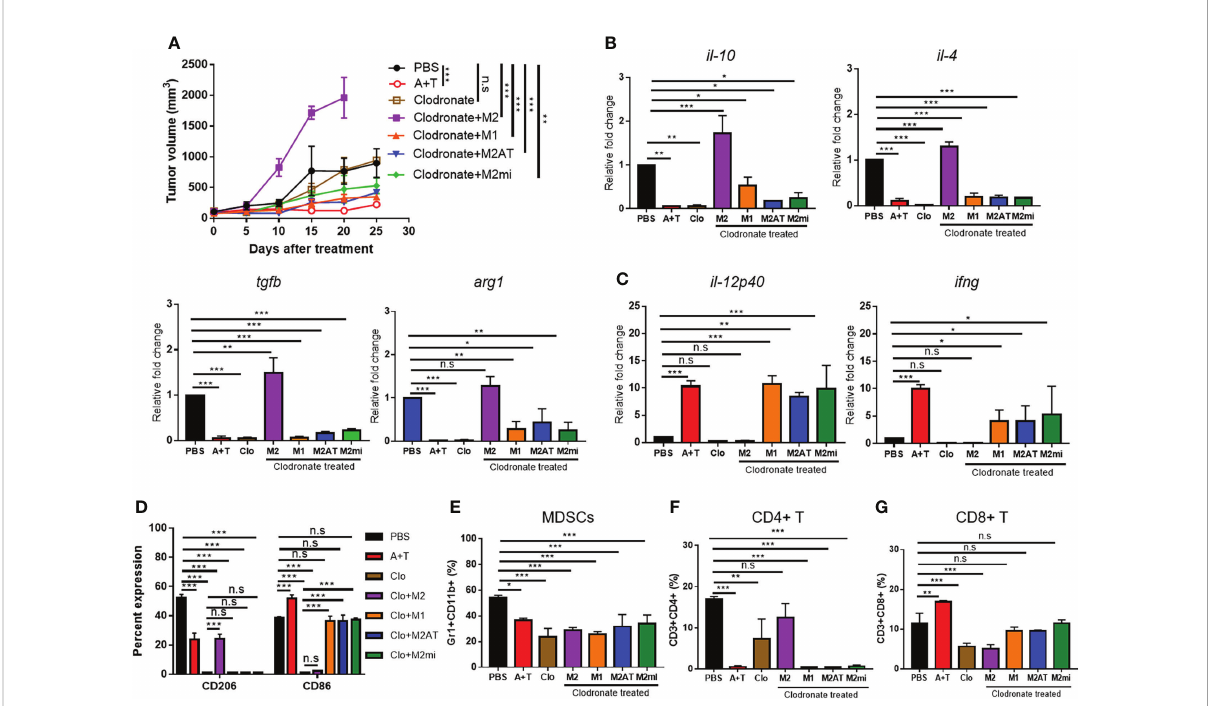
FIGURE 6 Adoptive transfer of M2 macrophages pre-treated with miR-7083-5p or combination of 5-aza-dC and TSA reduces tumor growth. (A) Tumor volumes after treatment of 4T1 tumor-bearing mice with clodronate and subsequent adoptive transfer of M2 macrophages pre-treated with miR-7083-5p (M2mi) or combination of 5-aza-dC and TSA (M2AT). M1 and M2 macrophages were included as control. (B, C) qRT-PCR analysis of the relative mRNA levels of M2- (B) and M1-type (C) cytokines and markers in tumor tissues after treatments. (D – G) Flow cytometric analysis of the population of CD206 + M2 macrophages and CD86 + M1 macrophages (D) , CD11b + Gr1 + MDSCs (E) , CD4 + T cells (F) , and CD8 + T cells (G) in the tumor tissues after treatments. A+T, combined treatment with 5-aza-dC and TSA. Clo, clodronate. Data represent the mean ± SD. *, P <0.05; **, P <0.01; ***, P <0.001; n.s., not signi fi cant ( n =3 mice per group), as assessed using one-way ANOVA followed by Tukey ’ s multiple comparison post-hoc